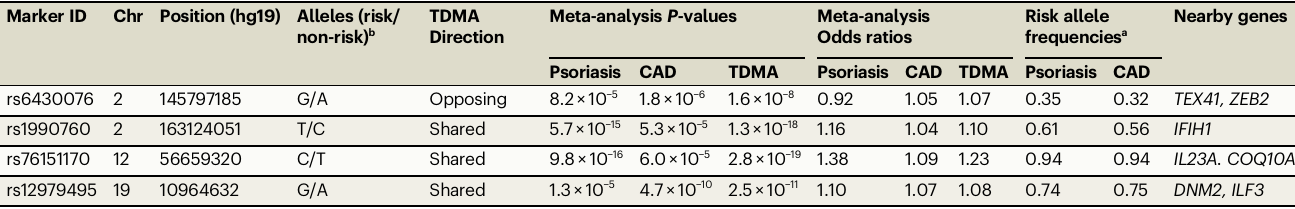
Chr chromosome, OR oddsratio, p p -value, CAD coronaryartery disease. a Allelefrequencies are provided for eachentire meta-analysis (cases and controls), rather than speci fi cally for eachdisease. b Risk allelecorresponds toTDMA.